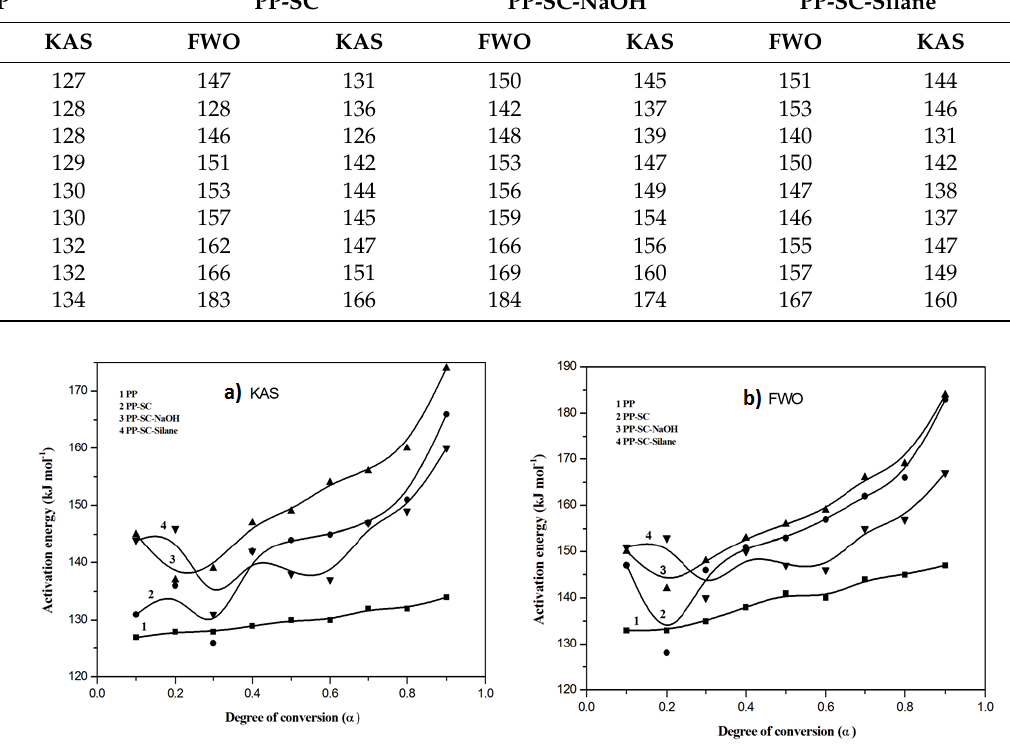
Figure 4. Activation energy values as a function of degrees of conversion obtained by ( a ) KAS and ( b ) FWO.